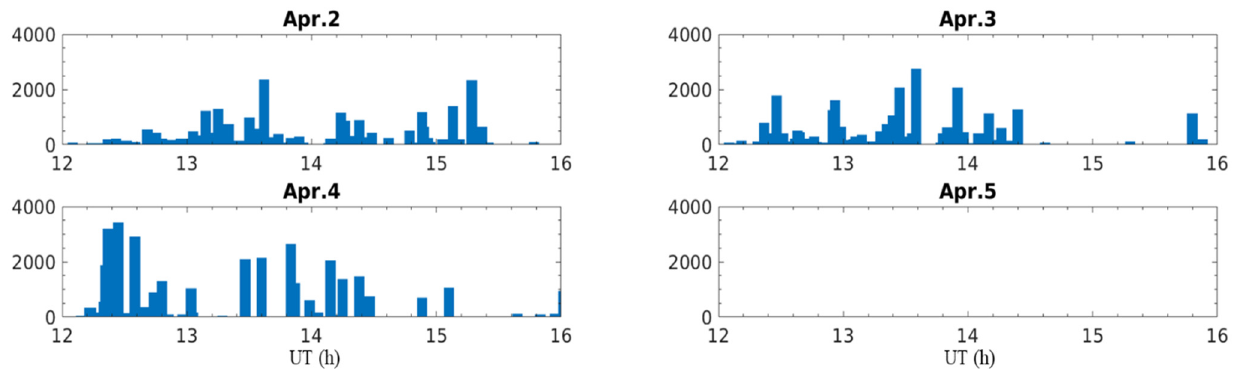
Figure 2. Lightning frequency and intensity obtained from the FY-4 satellite. The horizontal coordinate indicates the UTC in hours; the vertical bar indicates the sum of lightning events.